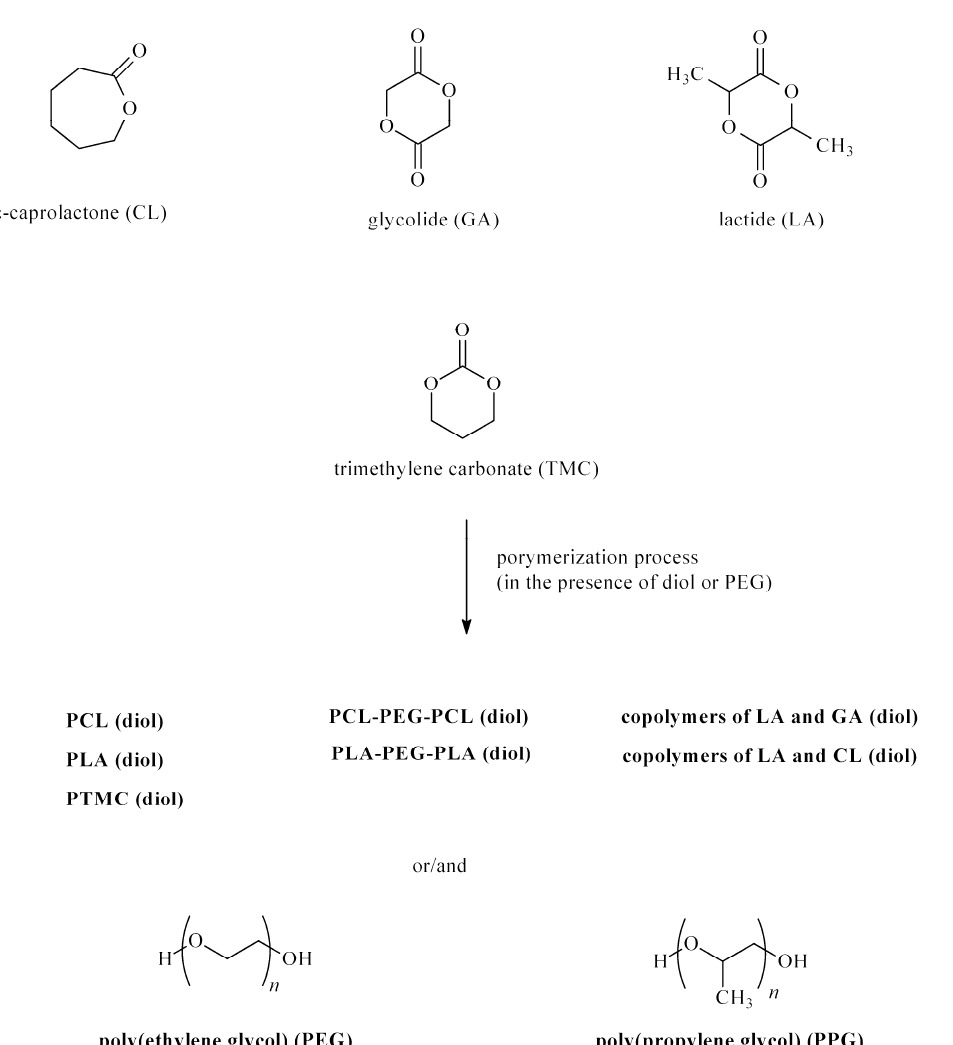
Figure 3. Polyols used for the synthesis of biomedical polyurethanes.